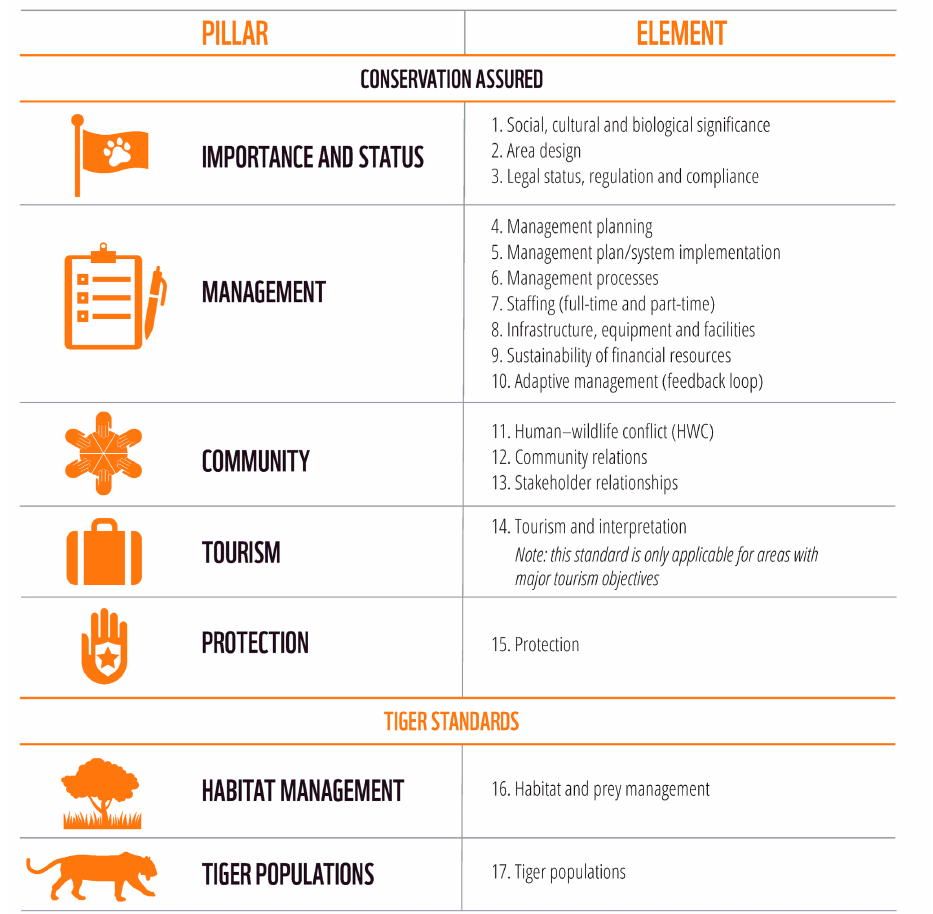
Figure 3. CA|TS pillars and